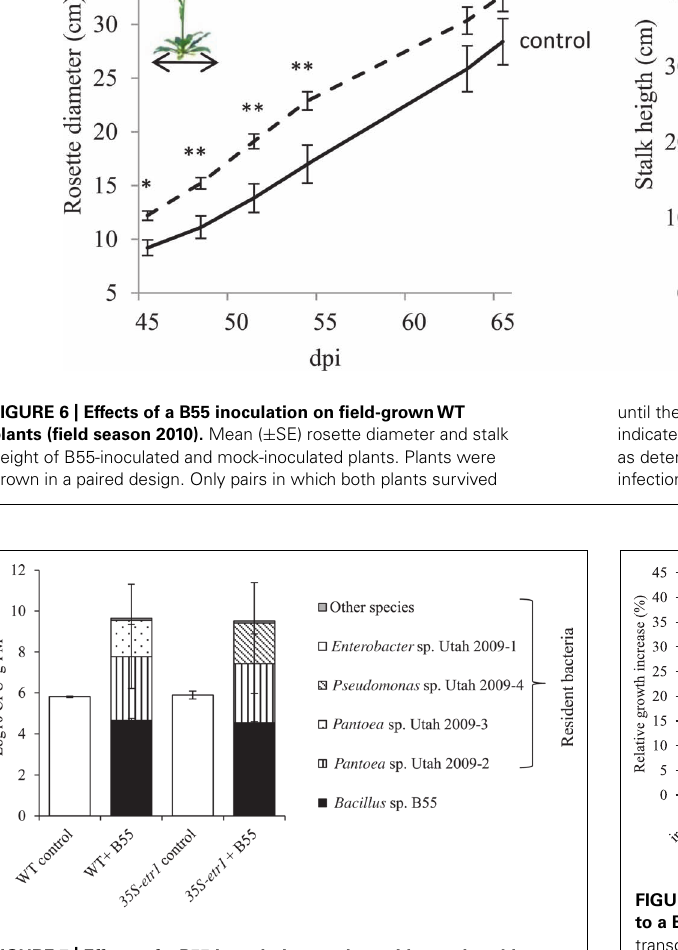
FIGURE 7 | Effects of a B55 inoculation on the resident culturable bacterial community of field-grown plants. Colony forming units of B55 and resident isolates at 73 dpi; see Table 1 for accession numbers of isolates. dpi, days post infection; CFU, colony forming units; FM, fresh mass. n = 3.